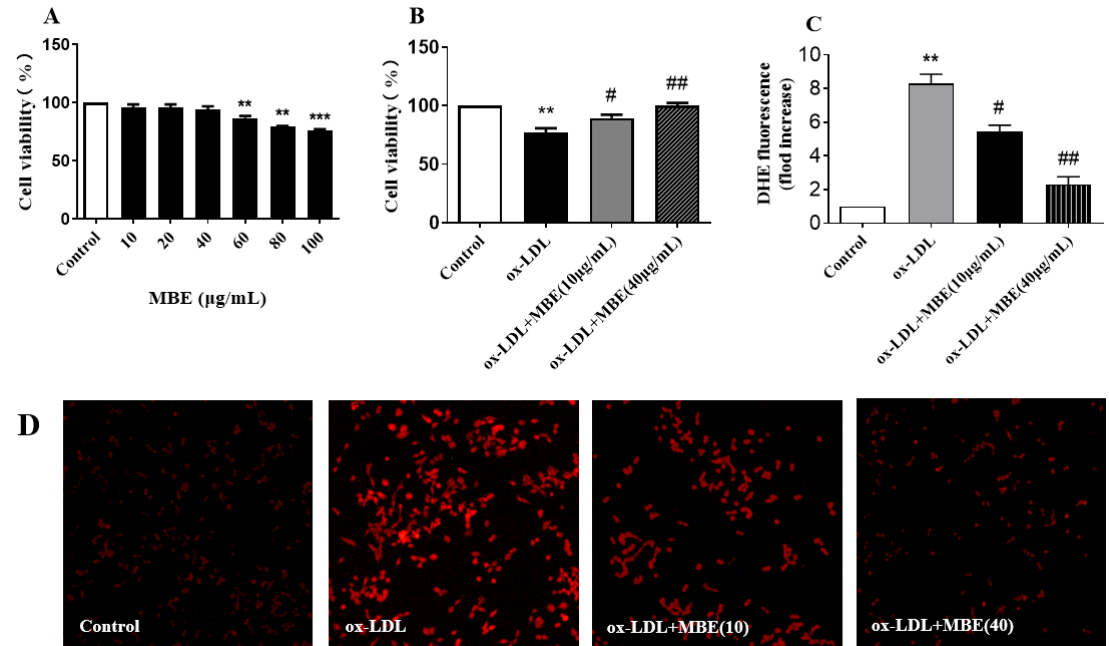
Figure 4. MBE ameliorated ox-LDL-induced damage in HUVECs. ( A ), Effect of MBE on the survival rate of HUVECs; ( B ), effect of MBE on the survival rate of ox-LDL-induced HUVECs; ( C ), relative content of ROS; ( D ), DHE staining of ROS. ** p < 0.01, versus control group; *** p < 0.001, versus control group; # p < 0.05, versus ox-LDL group; ## p < 0.01, versus ox-LDL group.